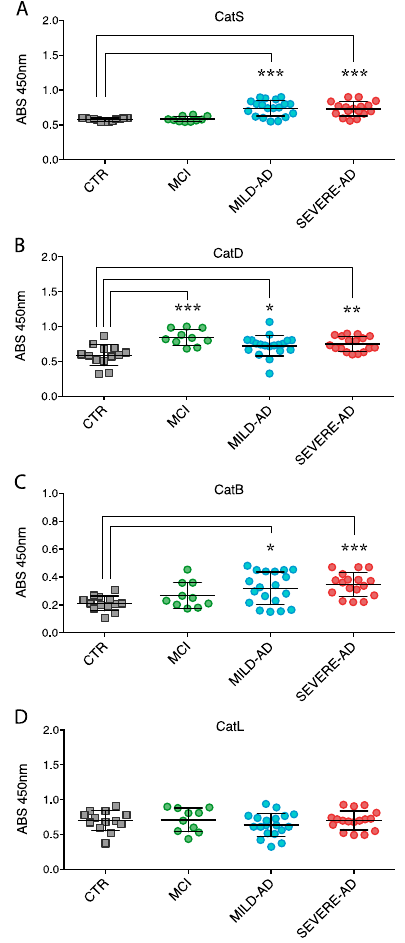
Figure 5. Lysosomal proteases expression ( A – D ) in plasma of mild AD, severe AD, MCI, and control subjects. Levels of proteases were determined in non-AD control group, mild AD and severe AD patients by using ELISA assay (see the Method section for details). Results were expressed as the mean ± SEM of five independent experiments, each in triplicates. * p < 0.05, ** p < 0.01, *** p < 0.001.